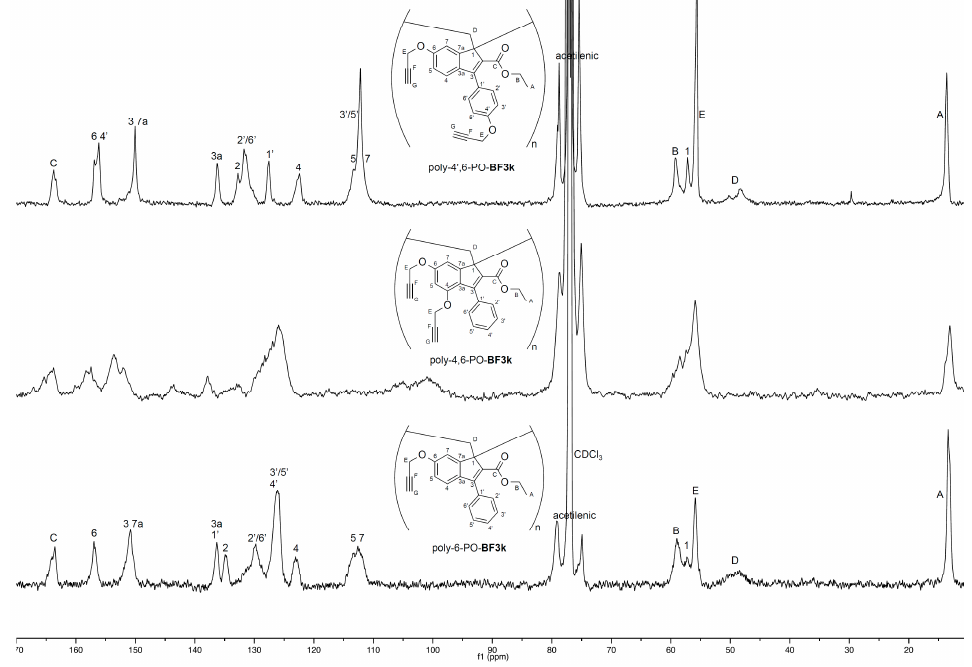
Figure 6. 13 C NMR spectra (CDCl 3 ) of poly-4’,6-PO- BF3k ( top trace ) and poly-4,6-PO- BF3k ( middle trace ) compared with that of previously reported poly-6-PO- BF3k ( bottom trace ).